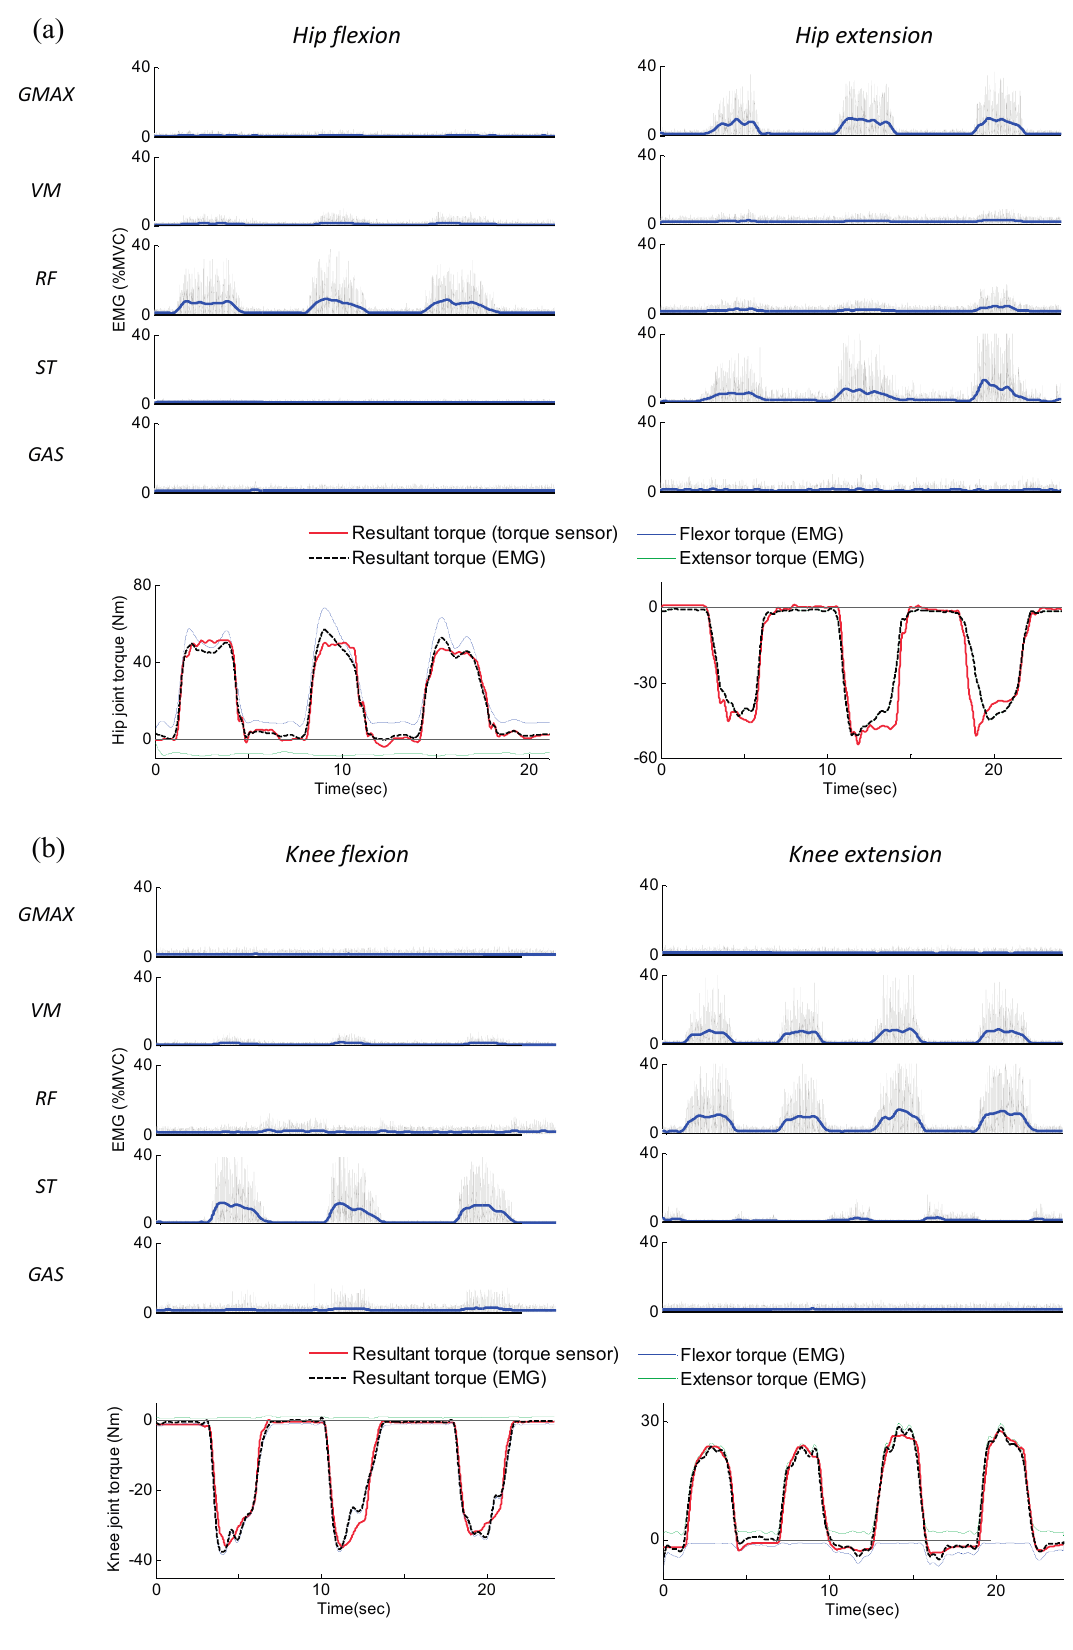
Figure 8. EMG signals and corresponding muscular torques resulting from the isometric calibration procedure (Subject 1). ( a ) Isometric hip flexion and extension; ( b ) Isometric knee flexion and